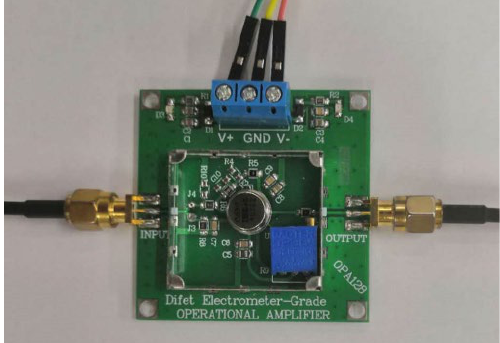
Figure 7. A prototype of charge-amplifying and conversion circuit.